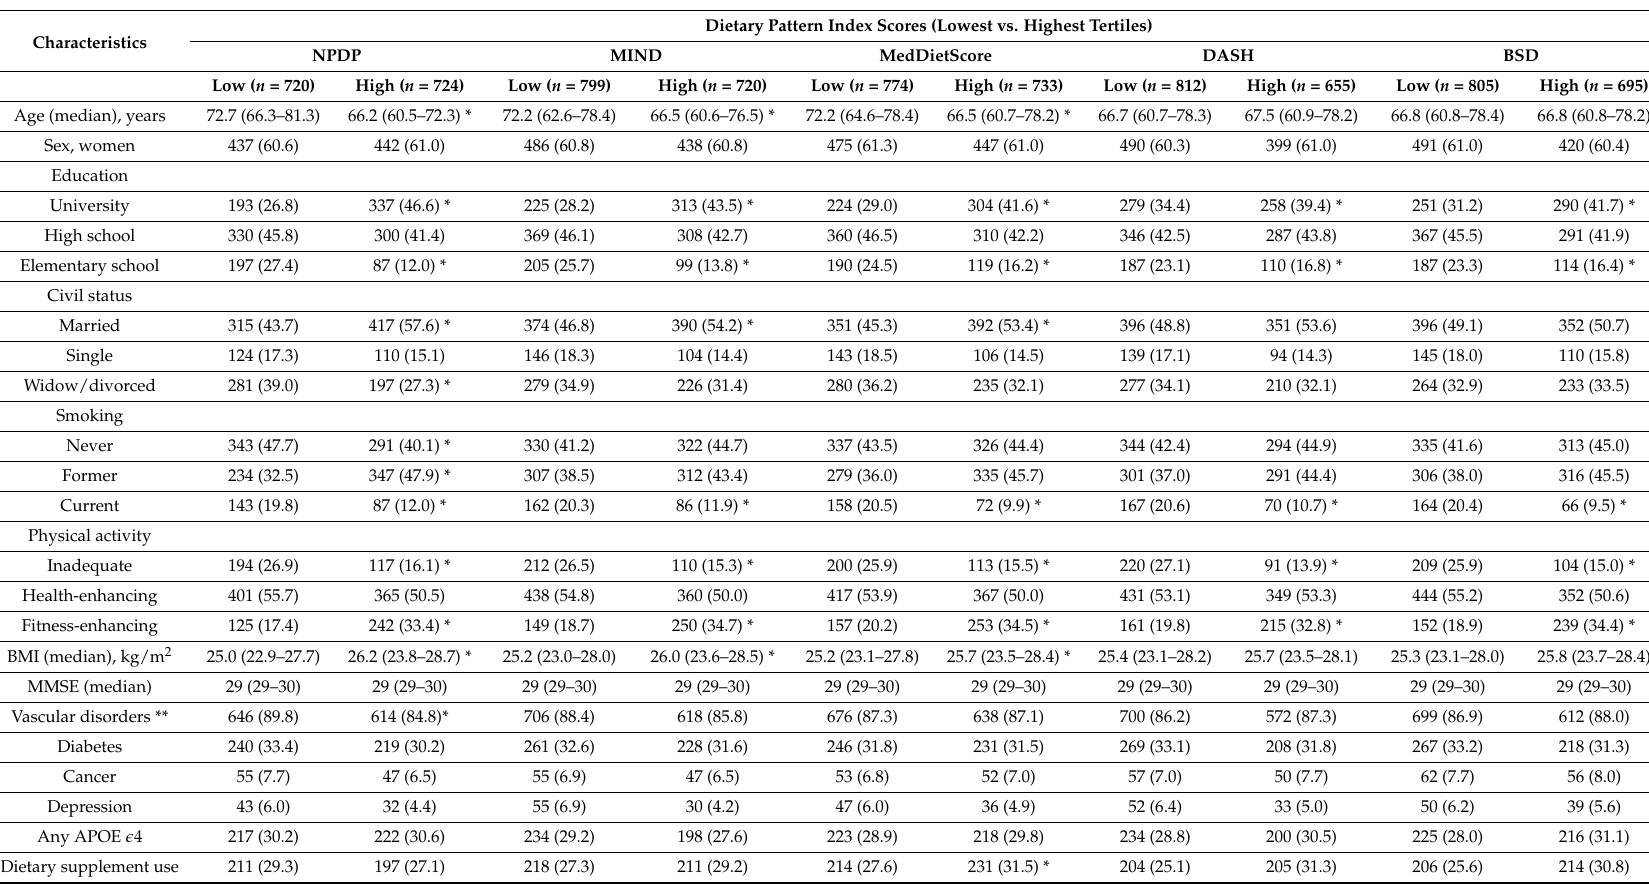
Table 2. Baseline characteristics of the study population by lowest (1st tertile) vs. highest (3rd tertile) adherence to different dietary patterns ( n =